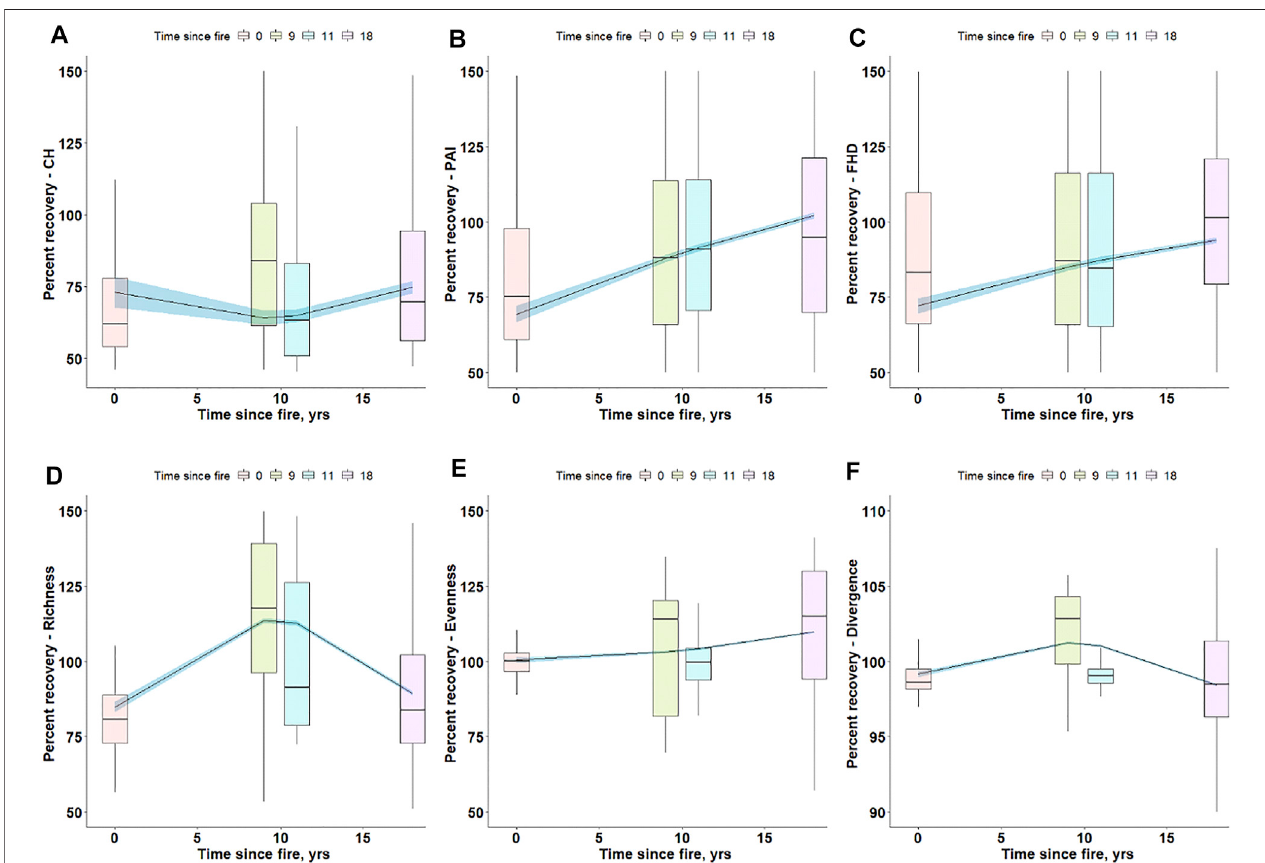
FIGURE 5 | Percent recovery of functional traits (A – C) and diversity (D – F) across the fi re chronosequence (1996 – 2014) predicted from ALS data. The box plots represent the percent recovery data distribution within a given year. The black line and blue shaded area represent the mean percent recovery and 95% con fi dence intervaloffunctionaltrait/diversitypost- fi re,respectively.Theboxplotsshowtherawdata(functionaltraitsanddiversity)distributionextractedfromburnedareascolored based on time since fi re.